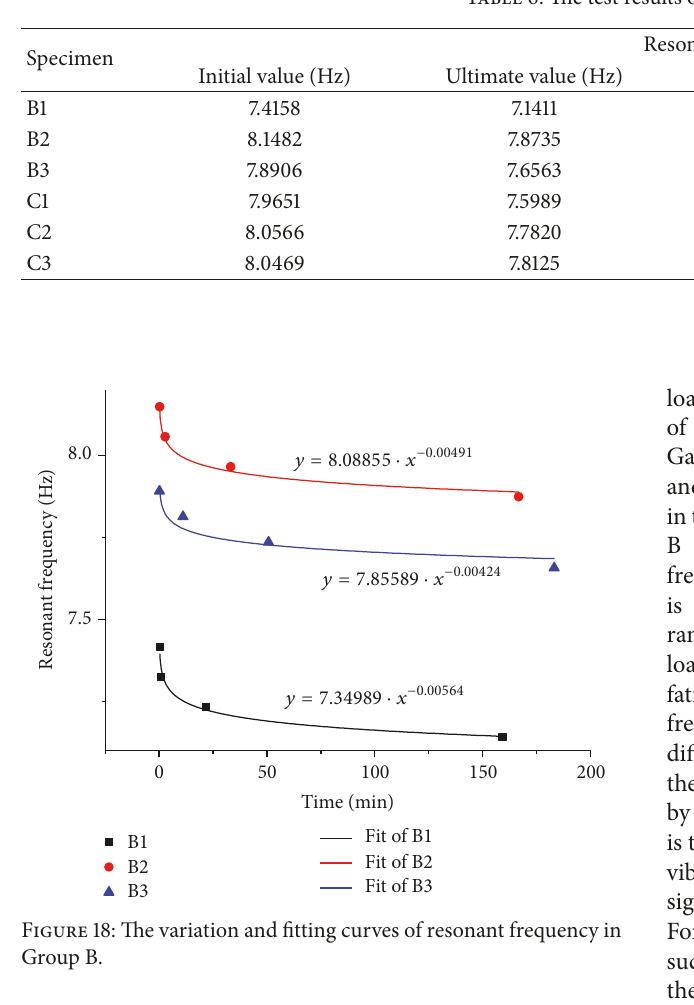
Table 6: The test results of Group B&C.